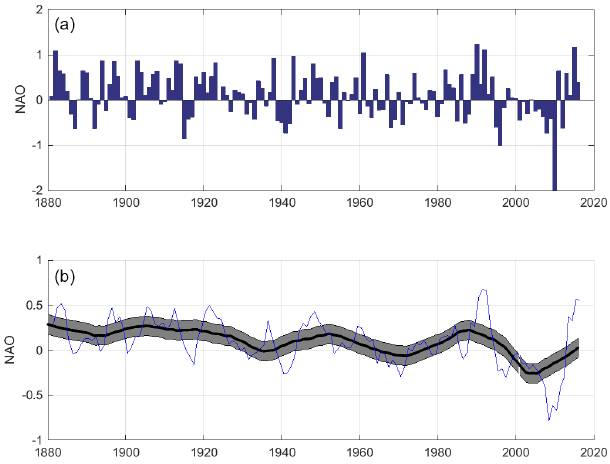
Figure 3. North Atlantic Oscillation (NAO) during 1880–2016. Panel (a) shows yearly NAO values and panel (b) shows the trend of the NAO, together with 5-year running mean values.